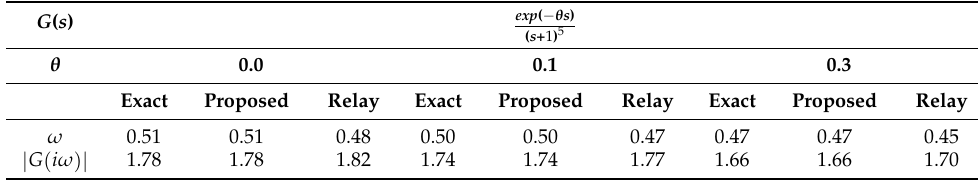
Table 4. Estimates of the proposed method and the relay feedback method [1] combined with the time delay [7] for the high-order plus time-delay process and PA set = − 3 π